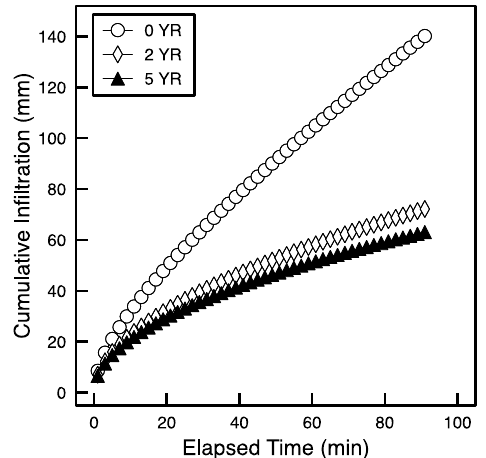
Figure 1. Cumulative infiltration curves fitted to Phillip’s model parameters for the three experimental plots subjected to different irrigation treatments (0YR, 2YR, and 5YR).